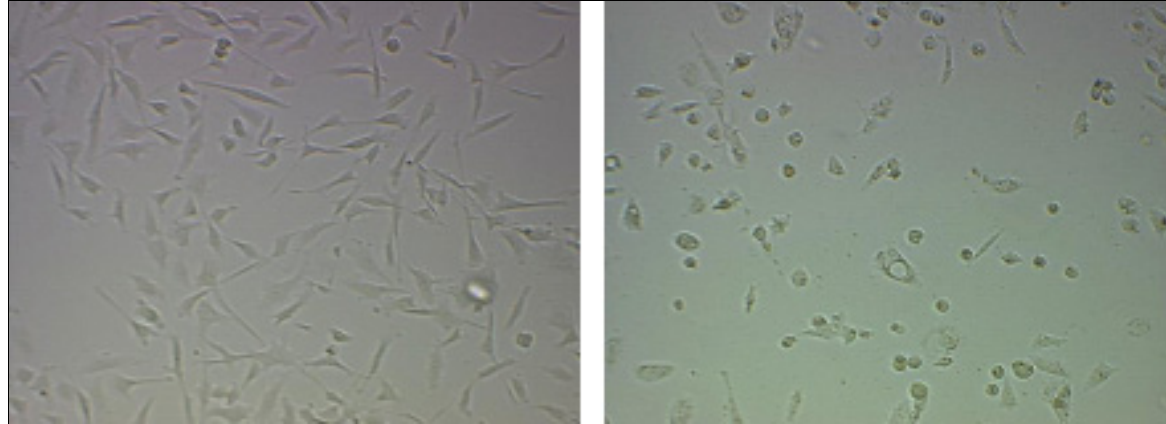
Figure 10. Microscope images of untreated ( left ) and transfected ( right ) PC3 cells. Treatment effect of 100 nM concentration of